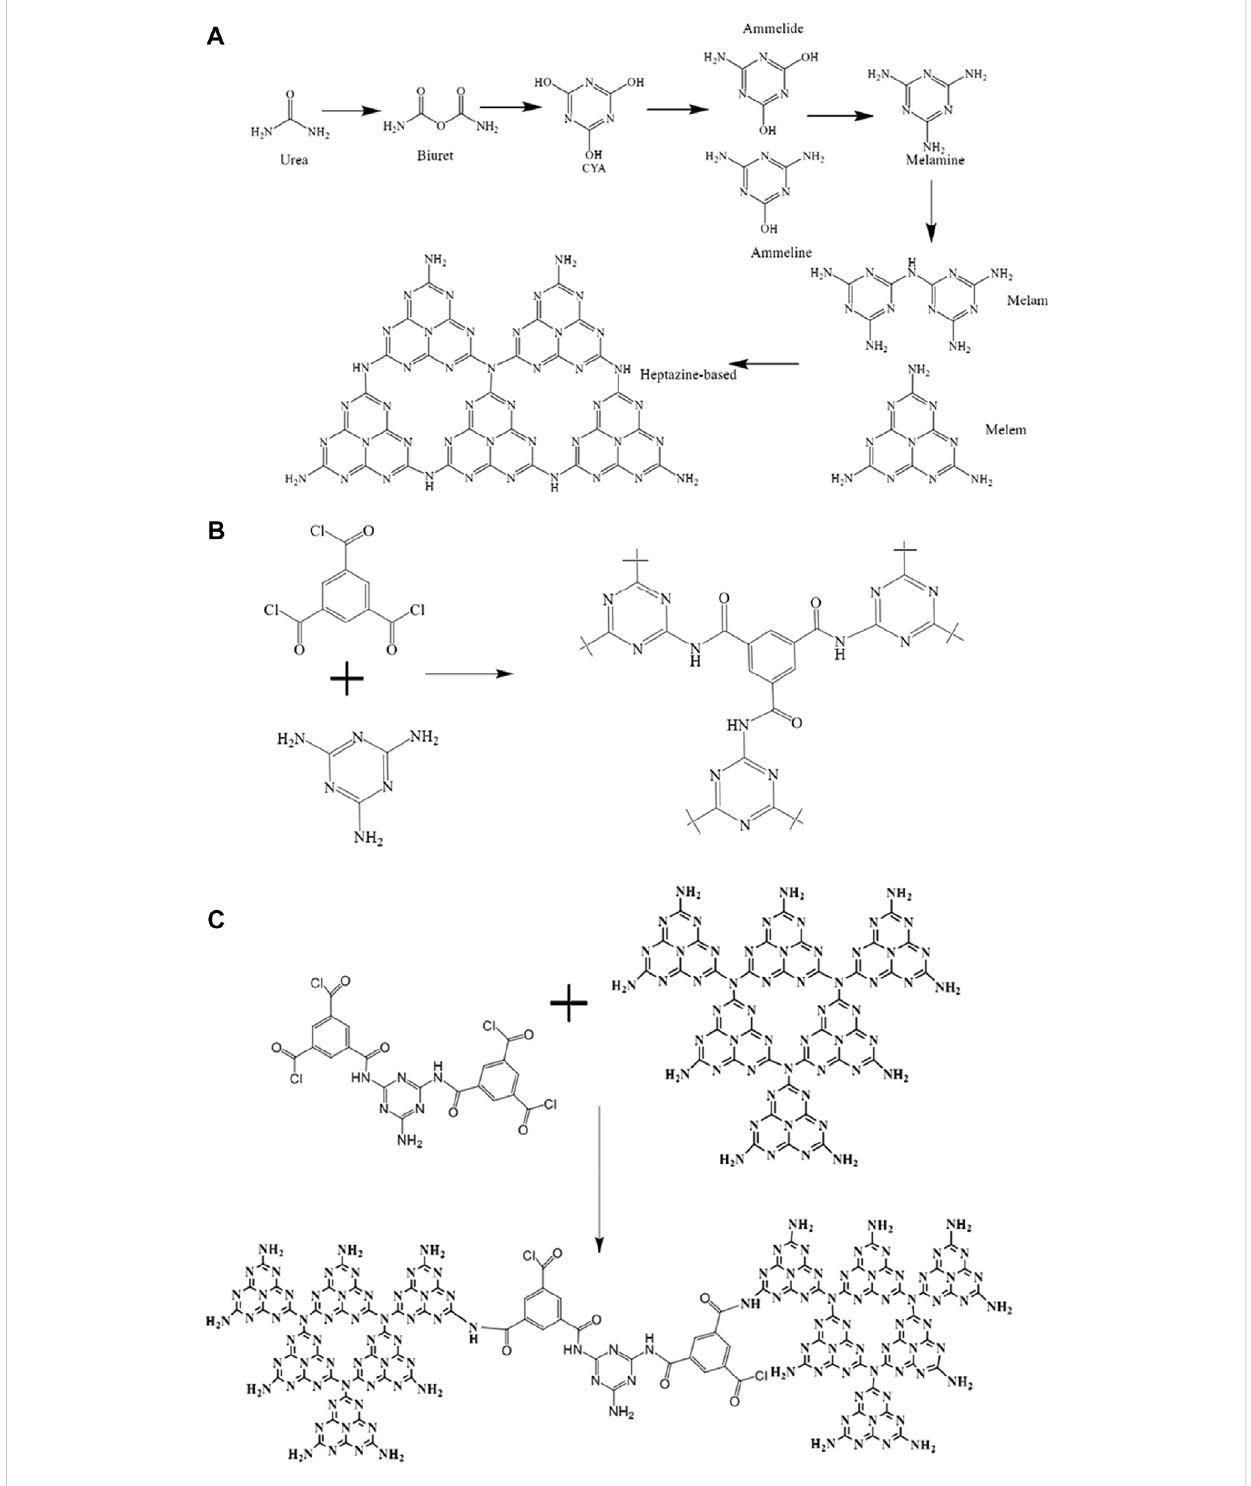
FIGURE 1 (A) The synthetic process for g-C 3 N 4 ; (B) MeTMC-COP; (C) a schematic showing how g-C 3 N 4 /MeTMC-COP is